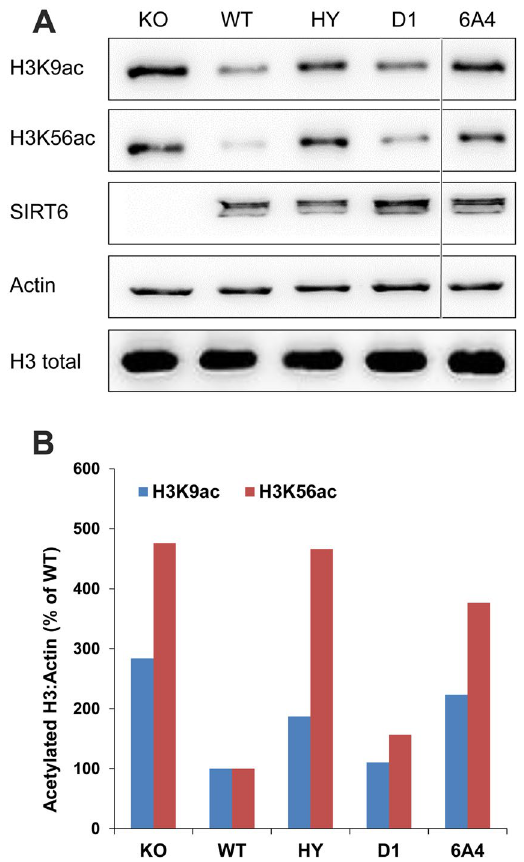
Figure 4. SIRT6 deacetylation of H3K9Ac and H3K56ac in MEFs. SIRT6 deacetylation activity was measured using western blot analysis with specific antibodies. Analysis was performed on crude cell lysates prepared from equal amount of KO MEFs cells that stably express the different SIRT6 variants, including WT, D1, 6A4 and the non-catalytic H133Y (HY). ( A ) Western blot analysis, the line highlights the deletion of non-relevant mutant’s analysis from the gel (original blots are shown in Supplementary Fig. S9) ( B ) Quantification of the western blot by image J to assess the activities of the D1 and 6A4 mutants relative to the WT and HY mutant. The western blot analysis is a representative gel from three independent